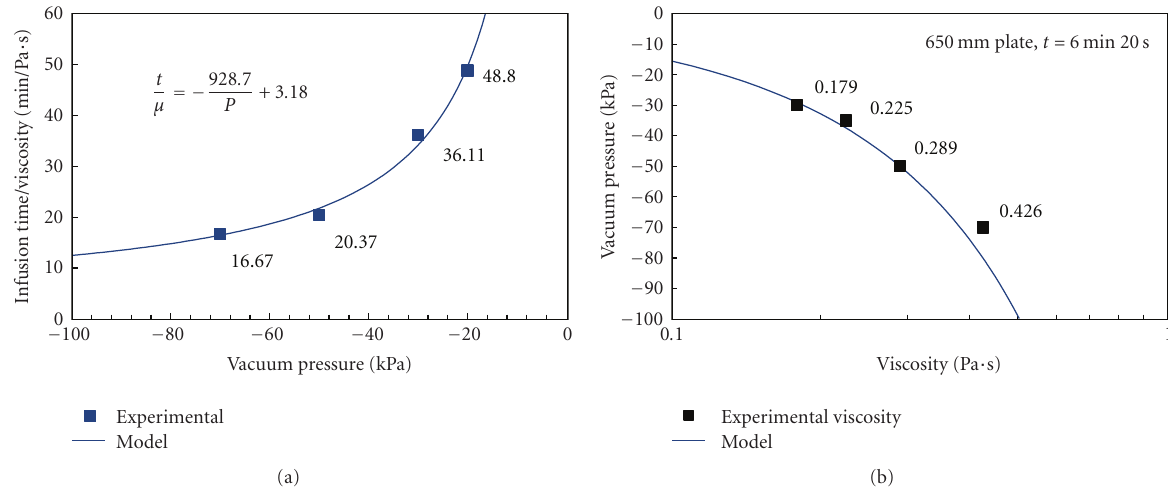
Figure 3: Optimization of SCRIMP process parameters (a) infusion time and (b) vacuum pressure required to obtain the same filling time.